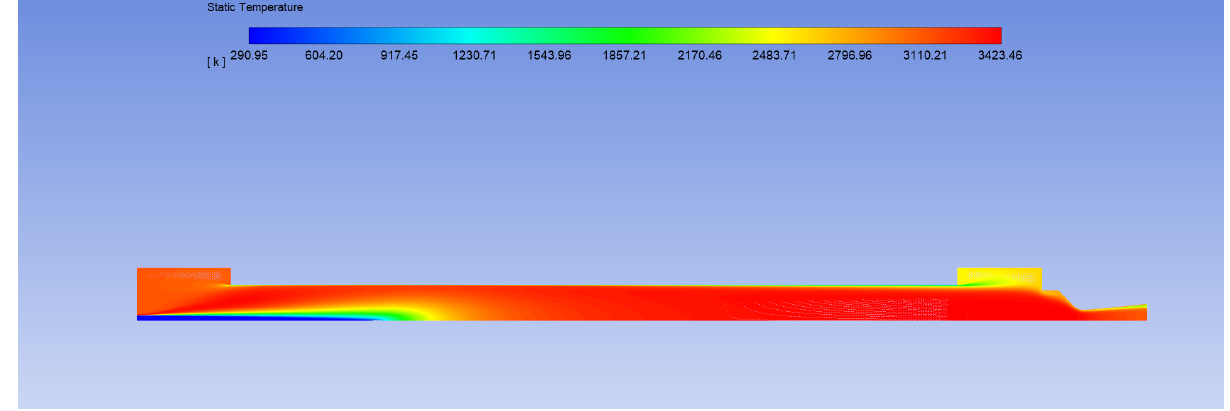
Figure 7. Temperature field of test 7—HDPE.